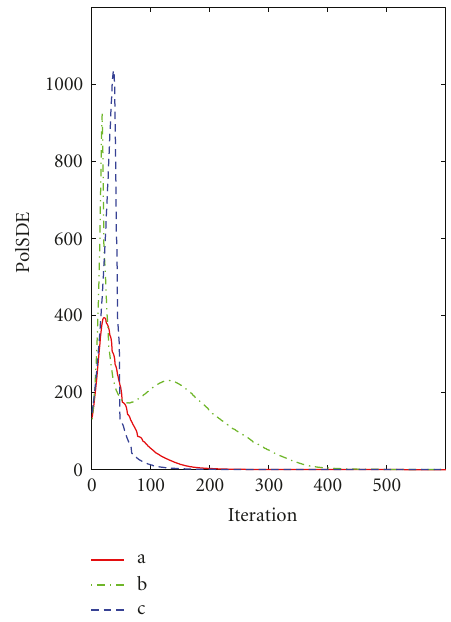
Figure 8: PolSDE versus iterations for di ff erent